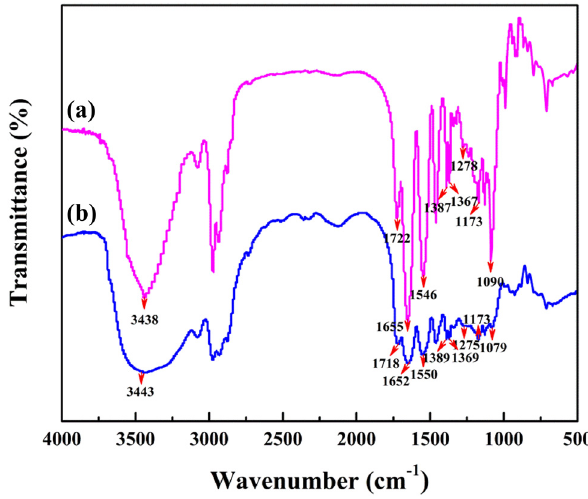
Figure 4: FTIR spectra of sprayed composite carriers ( a ) and PNIPAAm copolymers ( b )